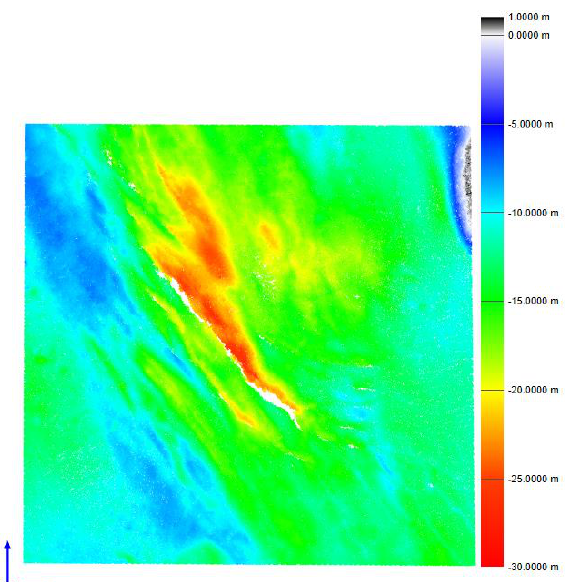
Figure 10. Height comparison map between 2014 DPC co- registered using CONFBLOCKS method and 2016 DPC: focus on Area3.